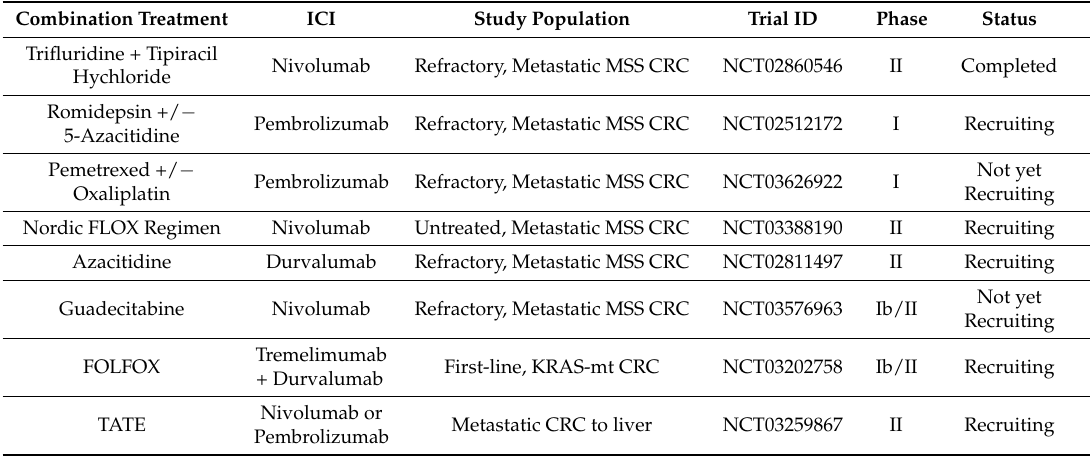
Table 1. Selected clinical trials of immune checkpoint inhibitors (ICIs) with chemotherapy in patients with colorectal cancer